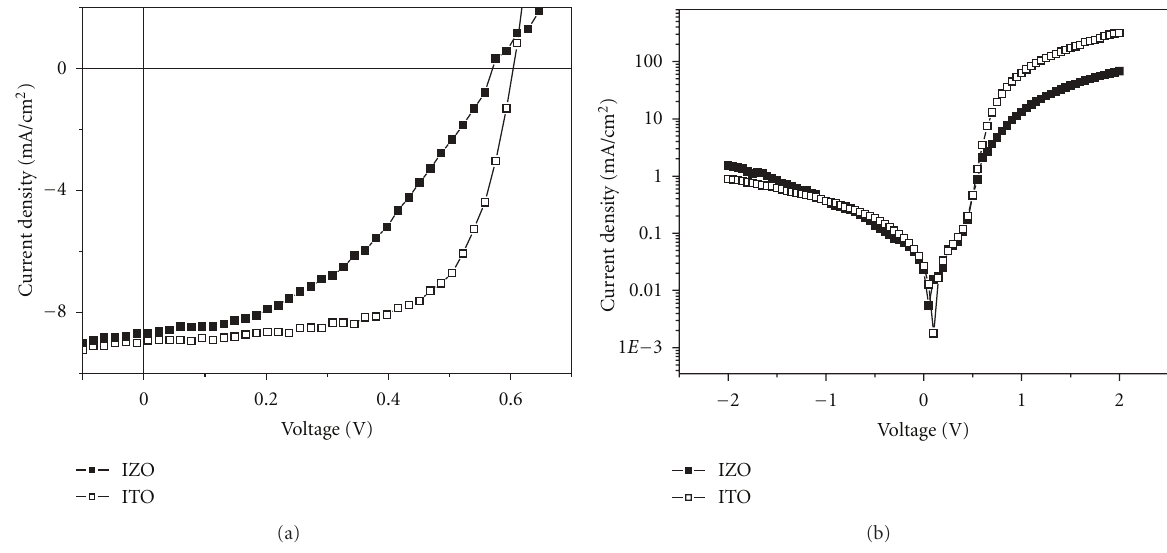
Figure 4: Current density-voltage ( J-V ) characteristics of FTO/PEDOT:PSS/P3HT:PCBM/LiF/Al and ITO/PEDOT:PSS/P3HT:PCBM/LiF/Al photovoltaic devices (a) under simulated AM 1.5 conditions and (b) in the dark. Table 1: Detailed performance parameters of the OPVs fabricated on the IZO- and ITO-coated glass substrates.